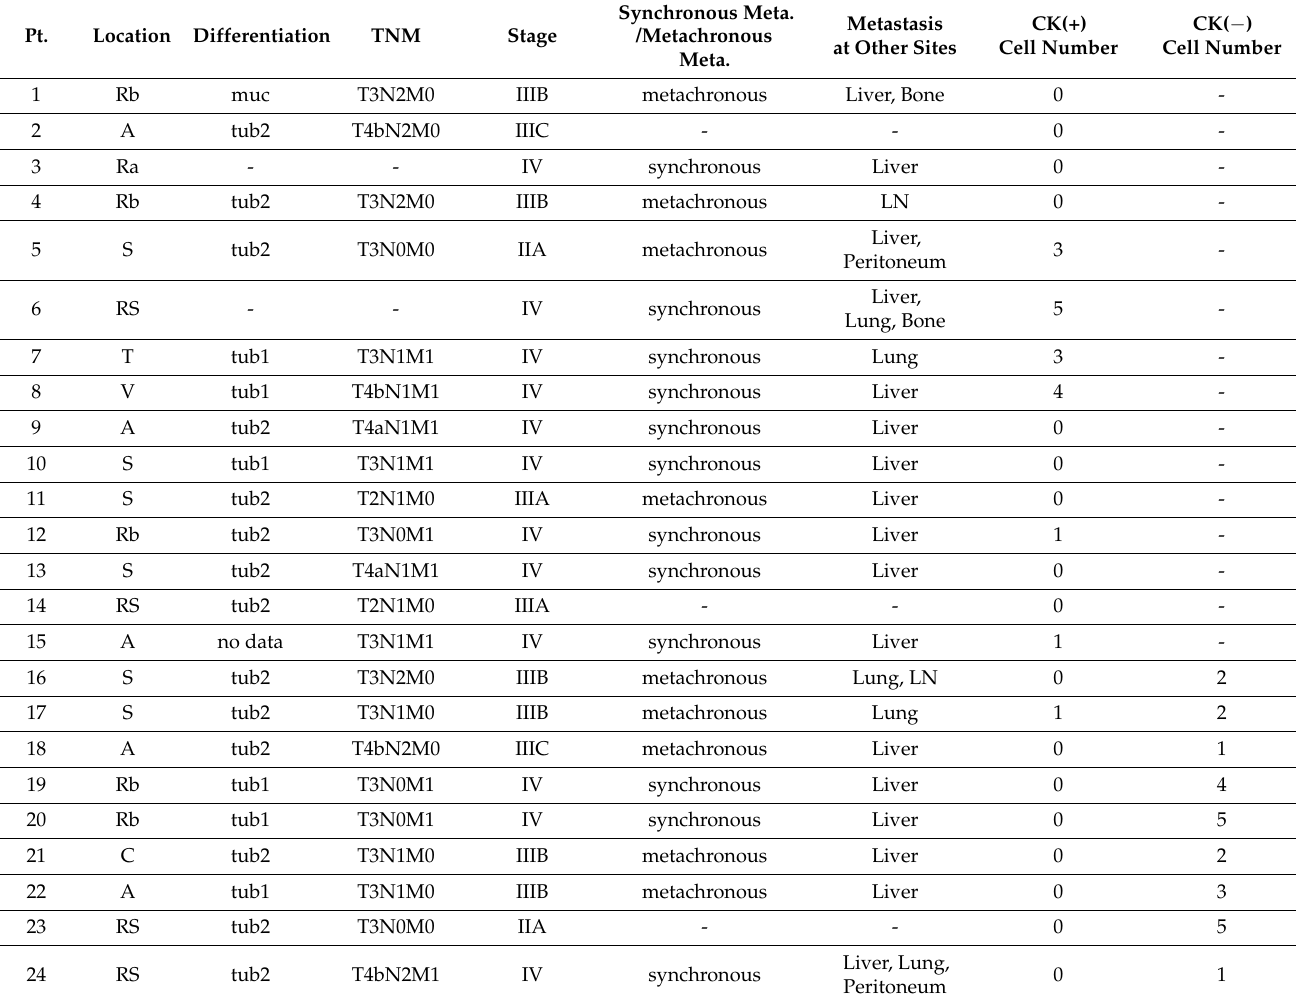
Table 2. Detection of CTC in CRC patients (n =